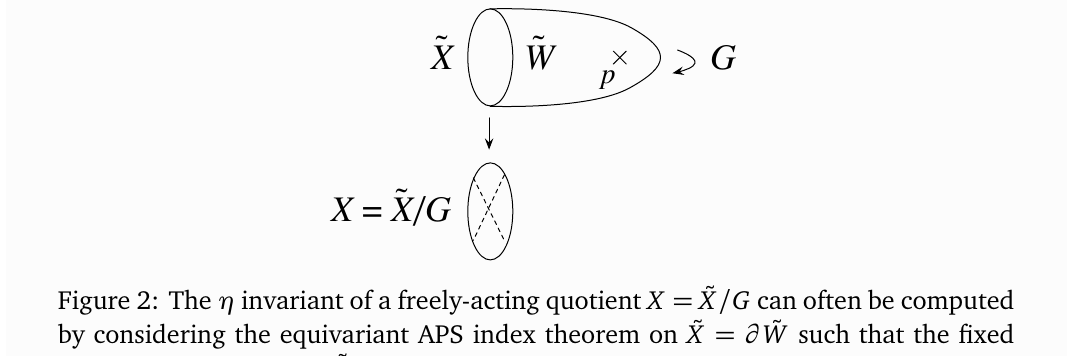
Figure 2: The η invariant of a freely-acting quotient X = ˜ X / G can often be computed by considering the equivariant APS index theorem on ˜ X = ∂ ˜ W such that the fixed points p of G action on ˜ W are